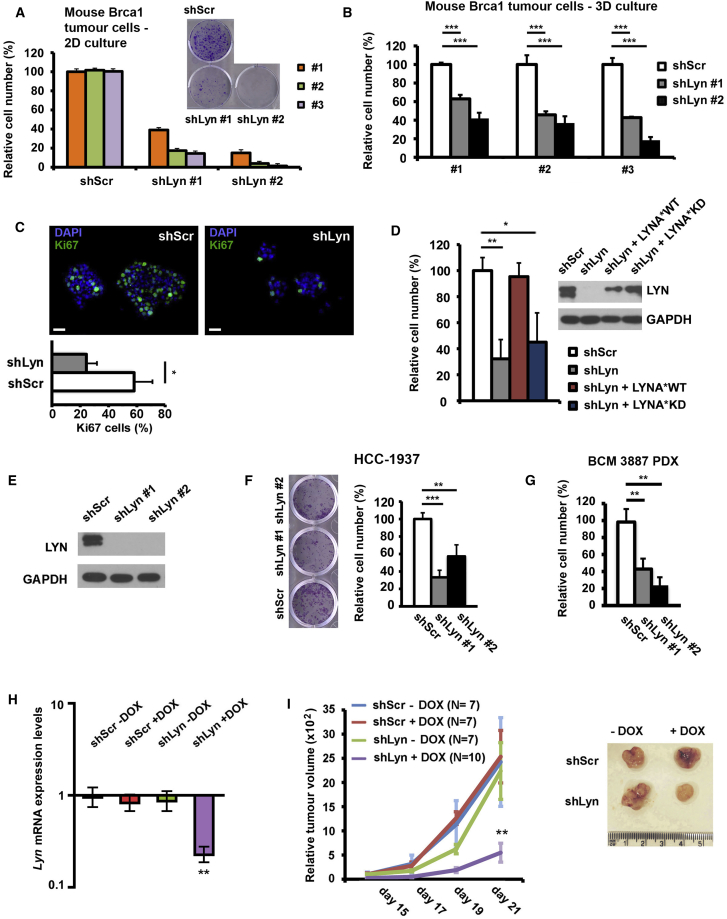
LYN Activity Is Required for Growth of Brca1 Tumor Cells(A) Primary cells isolated from three distinct BlgCre Brca1fl/flp53+/− mouse mammary tumors (1–3) were transduced with control (shScr) or Lyn knockdown (shLyn1 and shLyn2) lentiviruses, seeded at low density in adherent conditions (2D), and stained with crystal violet after 6 days. Viable cell density was determined by absorbance measurement following solubilization of the dye. Representative images of tumor cell colonies at day 6 of culture are shown.(B) shScr-, shLyn1-, or shLyn2-transduced BlgCre Brca1fl/flp53+/− tumor cells (1–3) seeded in Matrigel (3D) were assessed for growth after 6 days. Graphs show cell number assessed at day 5 of culture relative to shScr cells.(C) Ki67 immunofluorescence staining (green) of control (shScr)- and shLyn-transduced BlgCre Brca1fl/flp53+/− tumor cells in 3D culture 6 days after lentiviral transduction. Representative images and quantification of the percentage of Ki67-positive cells (n = 3). Scale bar, 20 μm.(D) Primary BlgCre Brca1fl/flp53+/− mouse mammary tumor cells were transduced with either lentiviral shScr and empty expression vectors (shScr), shLyn and empty expression vectors (shLyn), or shLyn and expression vectors carrying either an shLyn-resistant form (indicated by an asterisk) of wild-type LYNA (shLyn + LYNA∗WT) or a kinase-dead LYNA mutant (shLyn + LYNA∗KD). LYN protein levels determined by western blot 6 days after transduction. The graph shows cell number assessed at day 5 of culture relative to shScr cells.(E) HCC1937 cells were transduced with control (shScr) or Lyn knockdown (shLyn1 and shLyn2) lentiviruses and tested for LYN expression levels by western blot after 6 days.(F) shScr-, shLyn1-, or shLyn2-transduced HCC1937 cells were seeded at low density in adherent conditions. Viable cell density was determined after 7 days as in (A). Representative images show tumor cell colonies at day 7 of culture.(G) BRCA1 mutant PDX-derived cells (BCM 3887) were transduced with control (shScr) or LYN knockdown (shLyn1 and shLyn2) lentiviruses and tested for cell viability after 10–12 days of culture in 3D on Matrigel.(H) Primary mouse BlgCre Brca1fl/flp53+/− mammary tumor cells were transduced with pHIV-RFP-Tet repressor and pSEW-GFP-TO-H1 (carrying either shScr or shLyn) lentiviruses. Lyn levels were determined in cells transduced with either inducible shScr or shLyn and in either the presence or the absence of doxycycline (DOX) by qRT-PCR relative to shScr cells without DOX.(I) 250,000 inducible shScr- or shLyn-transduced cells were orthotopically injected into the fourth right mammary fat pad of nude mice. These were randomized to DOX treatment or normal diet, and tumor growth was monitored. Tumor volumes were calculated from caliper measurements of tumor width and length. Tumor growth curves (mean ± SEM) and representative images of endpoint tumors are shown.Blots are representative of three independent experiments. Unless otherwise stated, quantitation is shown as mean and SD (n = 3; for PDX cell experiments n = 3 cell isolations from 3 PDX implants in 3 mice; two-tailed unpaired t tests), except for gene expression analysis by quantitative real-time RT-PCR (mean ± 95% confidence intervals; significance of real-time RT-PCR data was determined from confidence intervals; n = 3 independent experiments for each of 3 technical replicates per sample) (Cumming et al., 2007). ∗p < 0.05; ∗∗p < 0.01; ∗∗∗p < 0.001. See also Figure S3.